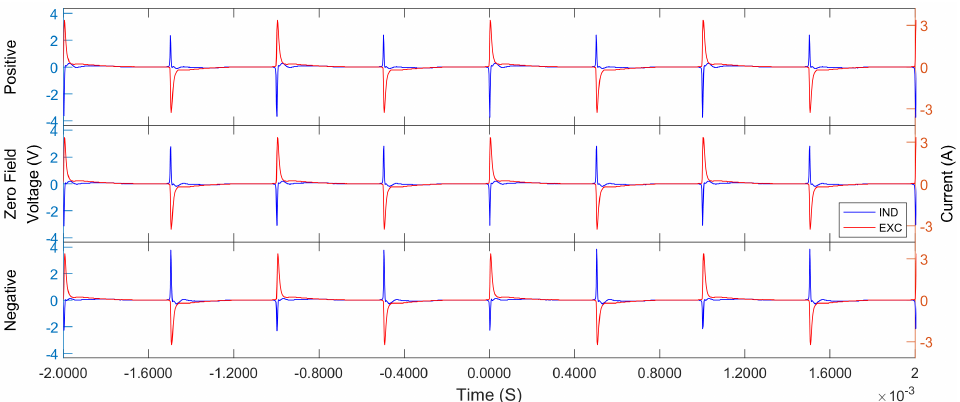
Figure 3. A sample of excitation signal versus induction signal in different ambient magnetic fields. The red curve named EXC represents the excitation current signal, and the blue curve named IND represents the induction voltage signal. The field was generated by Helmholtz coils in a shielding cylinder, which were equal in magnitude but opposite in direction. Zero-field condition is also